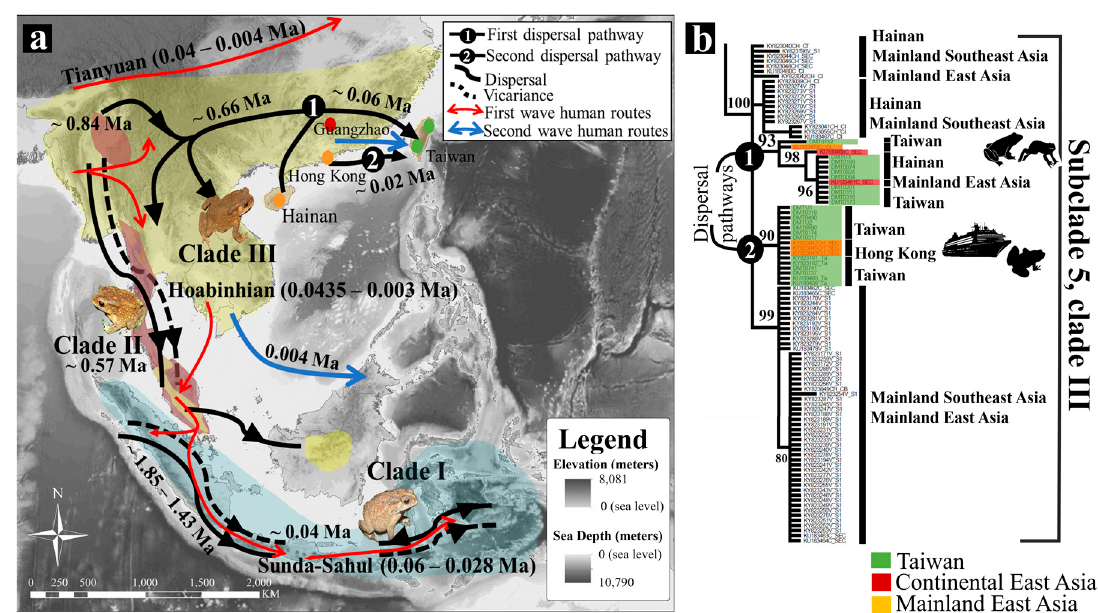
Figure 4. Hypothesised dispersal pathway of Duttaphrynus melanostictus in the Eastern Indomalayan realm. ( a ) The schematic diagram of predicted dispersal pathways for the three D. melanostictus lineages in the Indo Malayan realm integrating a model of prehistoric human dispersion from Southeast Asia during the Neolithic: Tianyuan (0.04–0.004 Ma), and Hoabinhian (0.0435–0.003 Ma) and Sunda-Sahul (0.06–0028 Ma); modified from Ji et al. (2016) [91], Yang et al. (2017) [92], Mccoll et al. (2018) [93], Gomes et al. (2015) [94], and the secondary human migration routes in Southern China post LGM adapted from Brandão et al. (2016) [95]. ( b ) Bayesian tree with an emphasis on the origin of contemporary population in Taiwan, either resulting from natural dispersion, or human mediated dispersion.